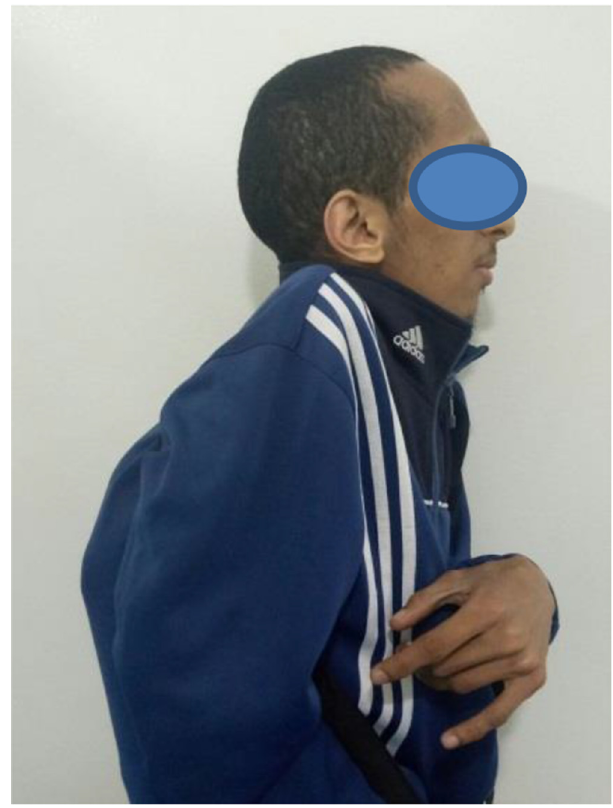
Fig. 2. Deformations related to heterotopic ossi fi cations in the back.